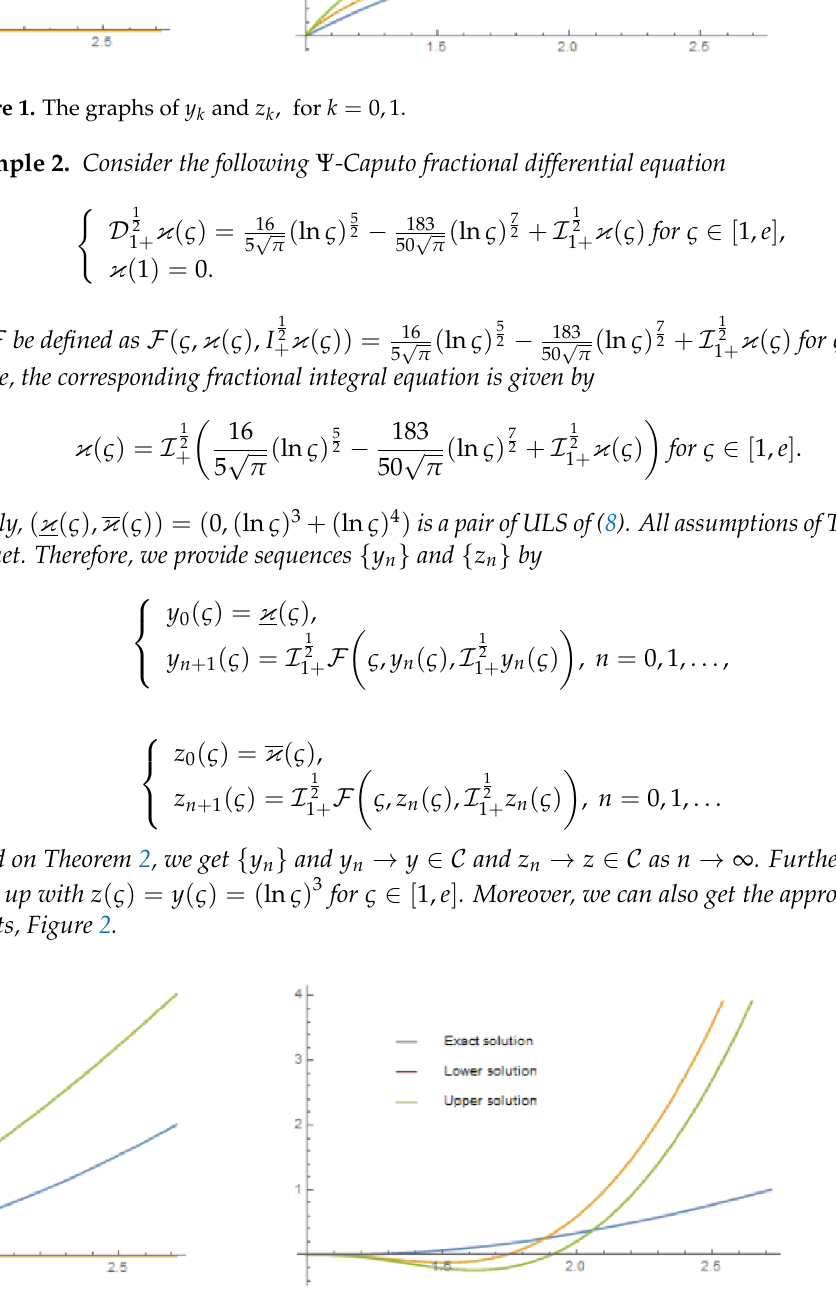
Figure 2. The graphs of y k and z k , for k =